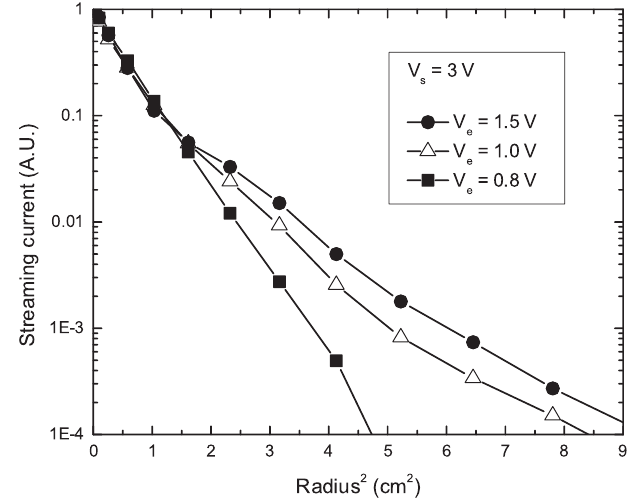
FIG. 6. Radial profiles of the axial streaming currents for several different extraction voltages with V 52 : 2 kHz . A straight line in the log versus r 2 plot indicates that the radial profile is a